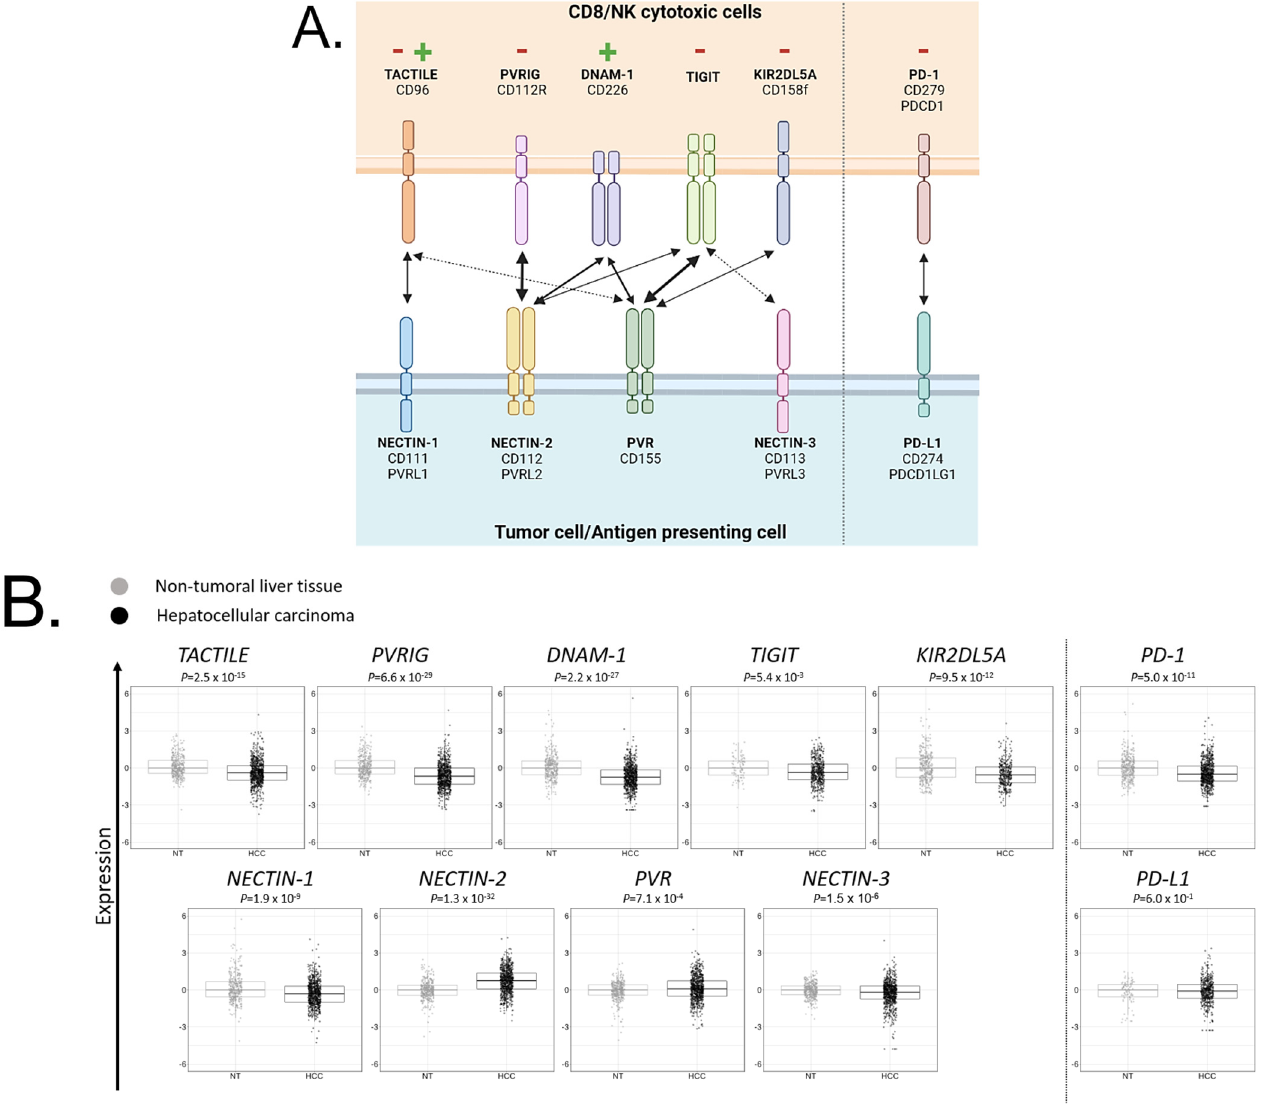
Figure 2. Members of the TIGIT/DNAM-1 axis and their respective gene expression in HCC and NT samples: ( A ) Members of the TIGIT/DNAM-1 axis and their respective ligands. TACTILE, PVRIG, DNAM-1, TIGIT, and KIR2DL5A are expressed on cytotoxic CD8 + T cells (CD8) and natural killer (NK) cells. NECTIN-1, NECTIN-2, NECTIN-3, and PVR are expressed on antigen-presenting cells (APC) or tumor cells. TACTILE binds NECTIN-1 and PVR with a stronger affinity for NECTIN-1. PVRIG binds NECTIN-2. DNAM-1 binds NECTIN-2 and PVR with equivalent affinity. TIGIT binds NECTIN-2, PVR, and NECTIN-3 with a stronger affinity for PVR and a weaker affinity for NECTIN-3. KIR2DL5A binds PVR. PVRIG, TIGIT, and KIR2DL5A contain immunoreceptor tyrosine-based inhibitory motif (ITIM) intracellular domain that triggers inhibitory signals, whereas DNAM-1 contains an immunoreceptor tyrosine-based activation motif (ITAM) intracellular domain that triggers activating signals. TACTILE signaling remains poorly described yet. PD-1/PD-L1 axis was added as a reference. Created with BioRender.com. ( B ) Gene expression level of each member of the TIGIT/DNAM-1 axis in NT and HCC liver tissues. PD-1 and PD-L1 were added as references. As a pre-screen strategy to identify which of these members was important to predict HCC outcome, we searched for a correlation between the gene expression of each member of the TIGIT/DNAM-1 axis and DFS and OS data. Gene expression was analyzed as a continuous variable. As shown in Figure 3, PVRIG and NECTIN-1 were the only members